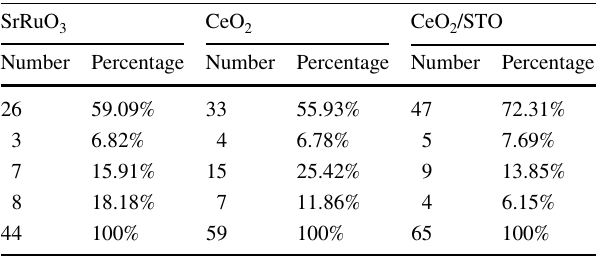
Table 1 Statistics of different result types from each thin film com‑ position